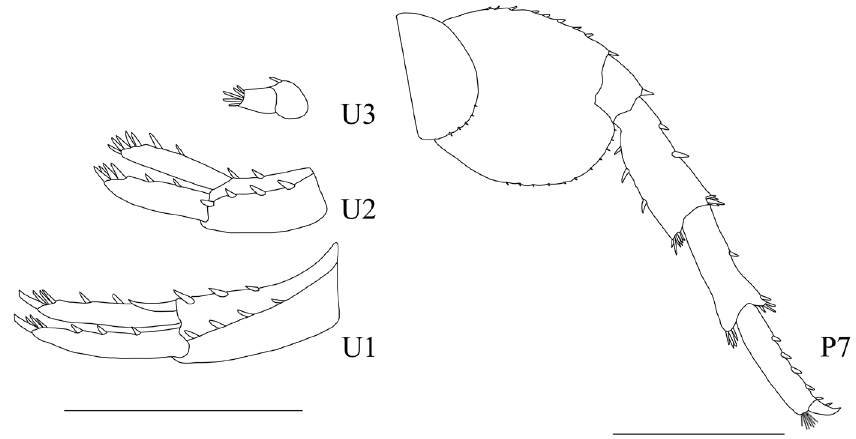
Figure 5. Illustration of male paratype of Parhyale explorator , from Ruffo’s collection, uropods I (U1), II (U2), III (U3) and peraeopod VII (P7). Scale bars 1